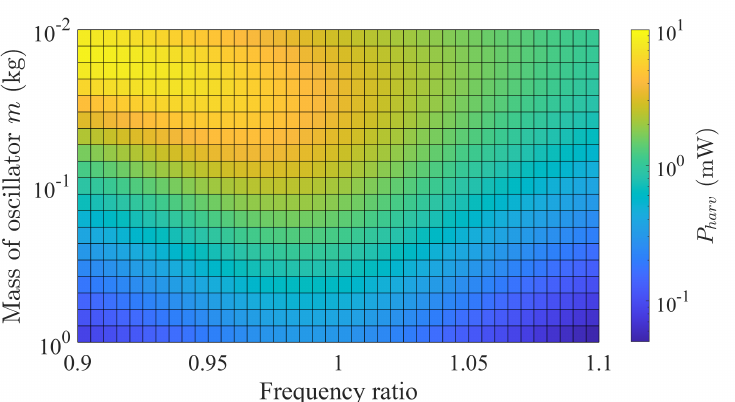
Figure 4. Simulated results of harvested power as a function of mass and frequency ratio.